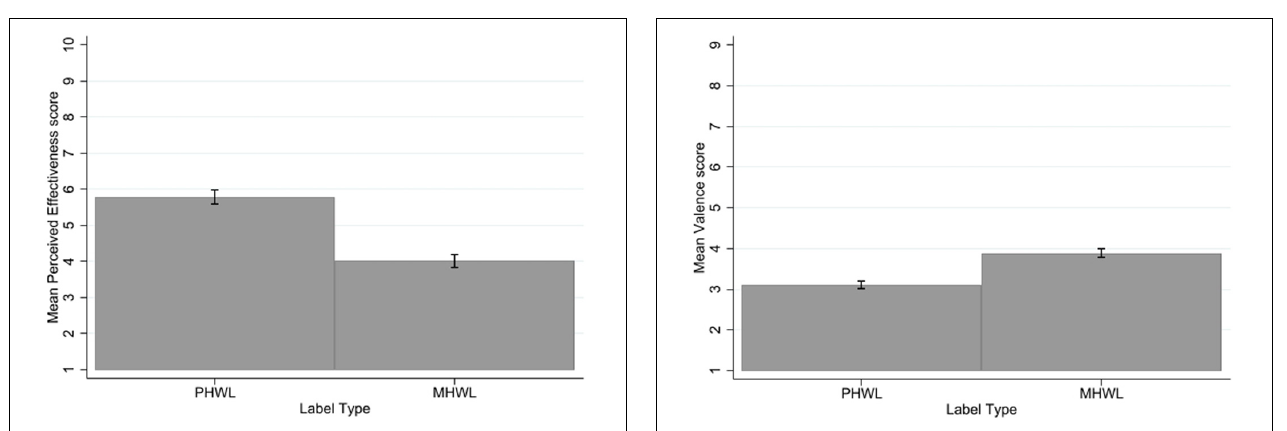
FIGURE 2 | Perceived effectiveness by label type. Error bars represent 95% confidence intervals.